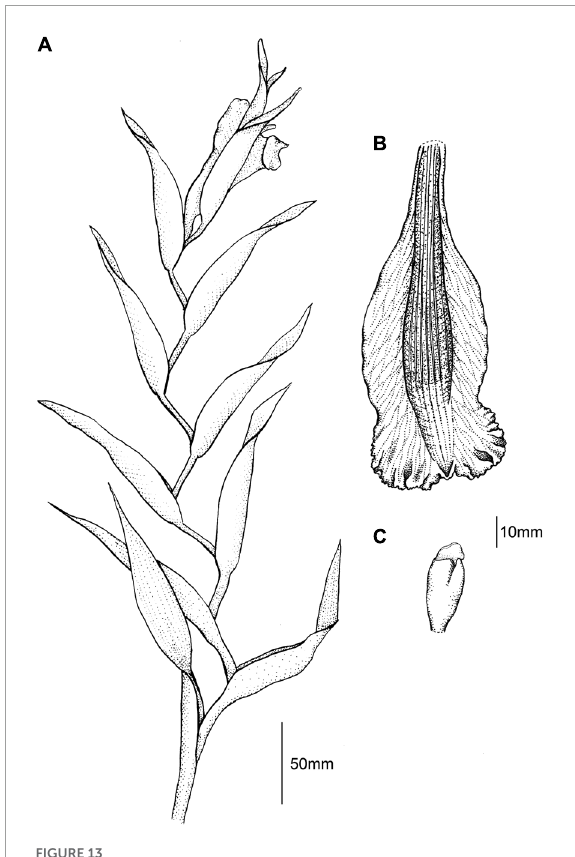
FIGURE13 Sobralia hoppii Schltr. (A) apical part of stem with the inflorescence, (B) lip, and (C) apical part of the gynostemium, side view (drawn by P. Baranow from the neotype).